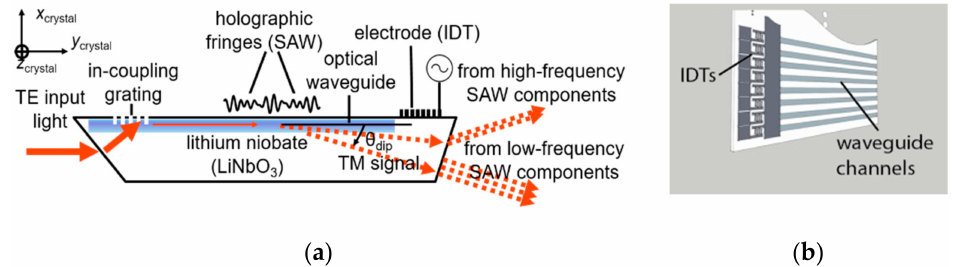
Figure 2. ( a ) Detailed cross-sectional illustration of an edge-exit leaky mode modulator in an arrange- ment in which a waveguided illumination counter-propagates with respect to holographic fringes induced by the IDT in response to an applied electrical waveform. Reproduced with permission from [9]. ( b ) Illustration of several leaky mode devices in an array. See also